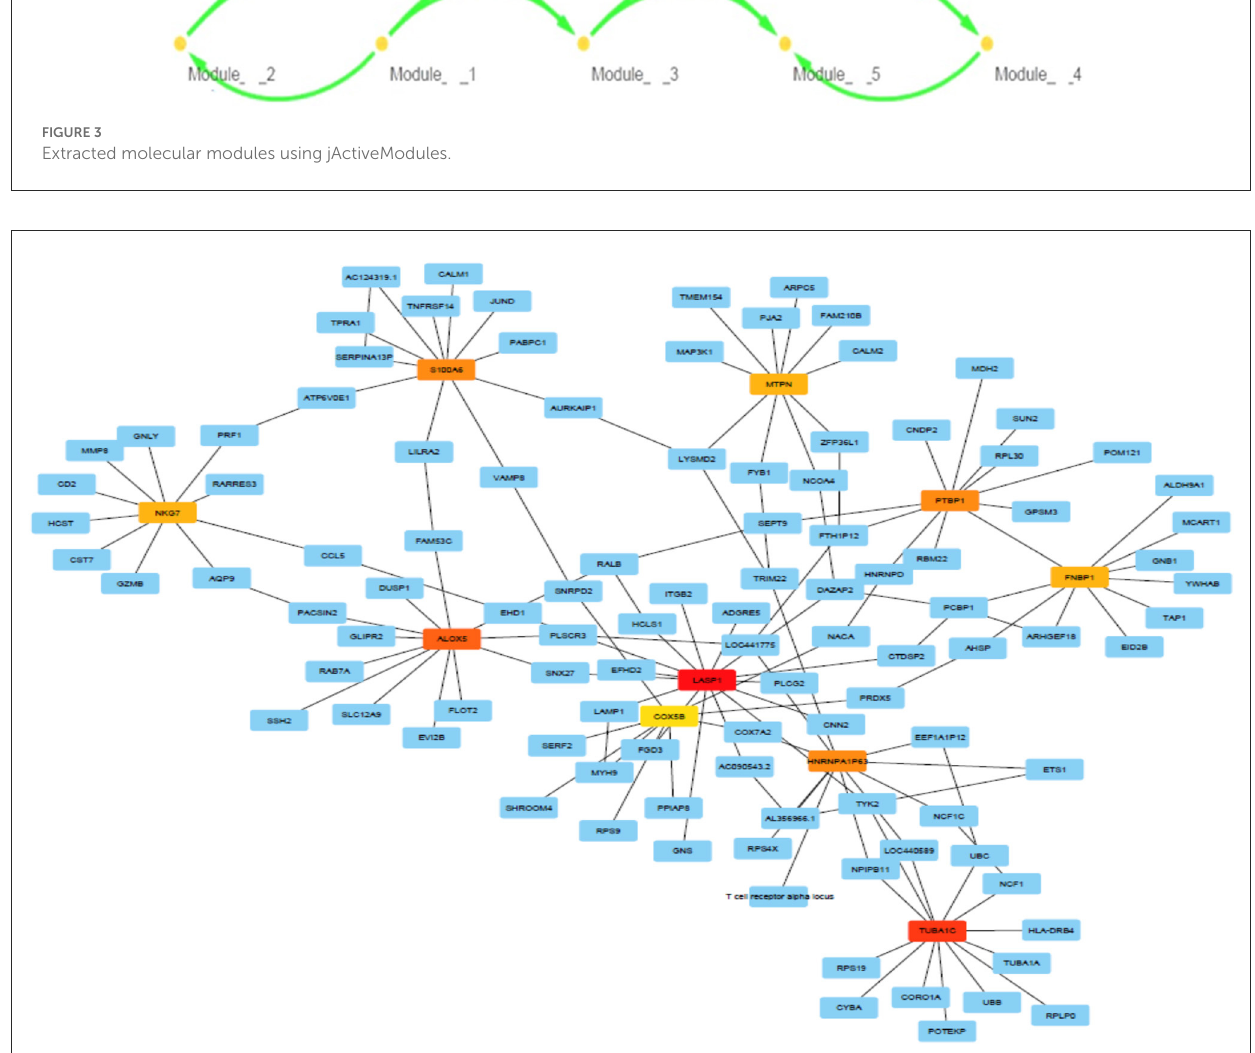
FIGURE4 The MCC method captures essential genes in the top ranked